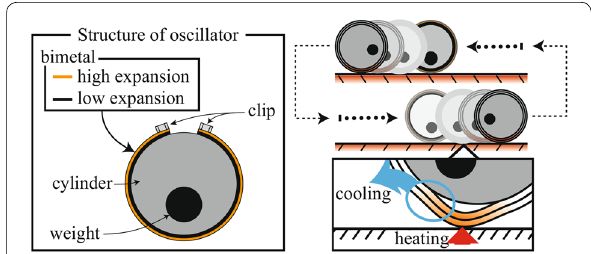
Fig. 2 Eccentric cylinder with bimetal sheet and its self‑oscillation on a hot plate (From [8], ©2015 IEEE)